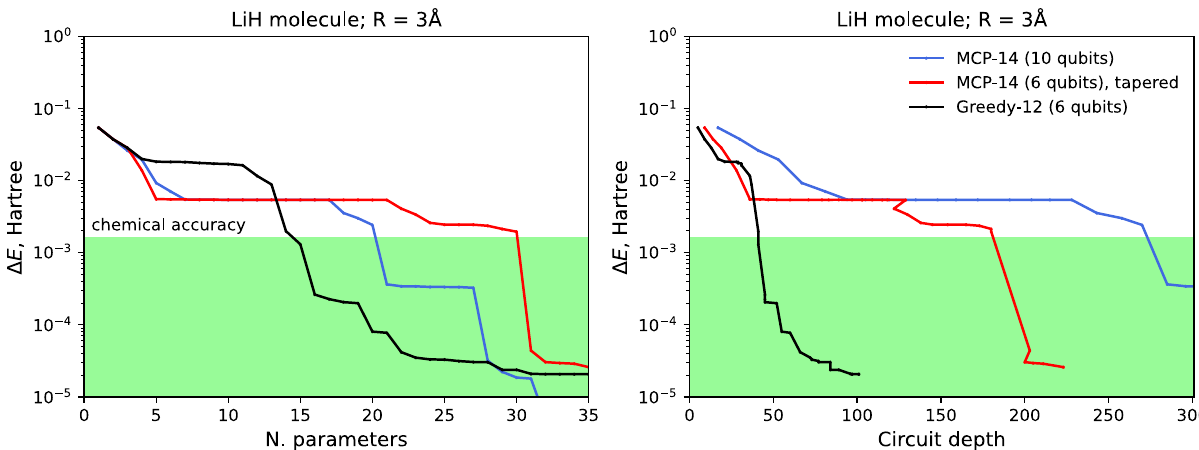
Fig. 4 Qubit ADAPT-VQE convergence of energy with respect to the number of parameters and the circuit depth for LiH molecule. The results are provided at molecular radius R equal 3.0 angstrom (Å). Δ E is the energy difference with the exact ground state energy in Hartree. MCP-14 is the minimal complete pool acting in the original qubit space of 10 qubits suggested in previous work 29 . `MCP-14, tapered' is built from MCP-14 by applying tapering procedure. Greedy-12 pool is a qubit linear complete pool constructed using the computational scheme proposed in this work and acts in a 6-qubit space. Table 1 Estimated resources for UCCSD ansatz with and without symmetry reduction.